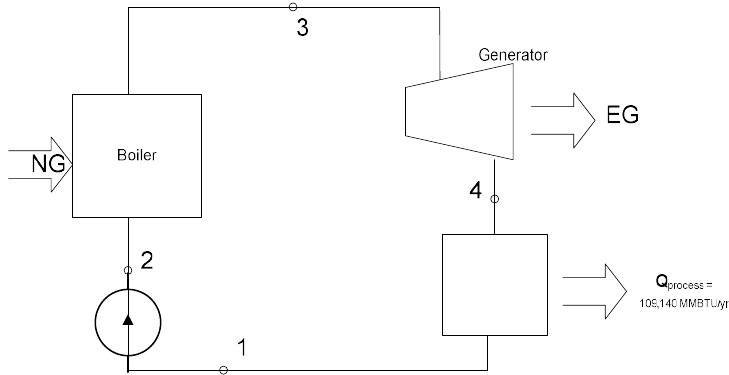
Figure 5. Model of the cogeneration system .